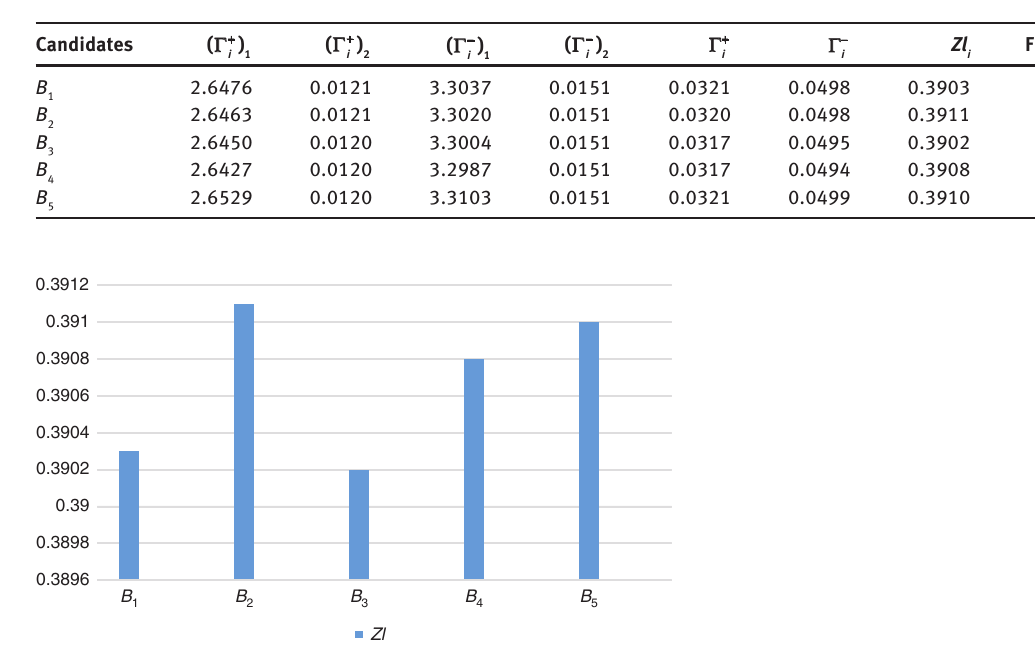
− and Zl by the proposed CF-MAGDM is shown in Table i